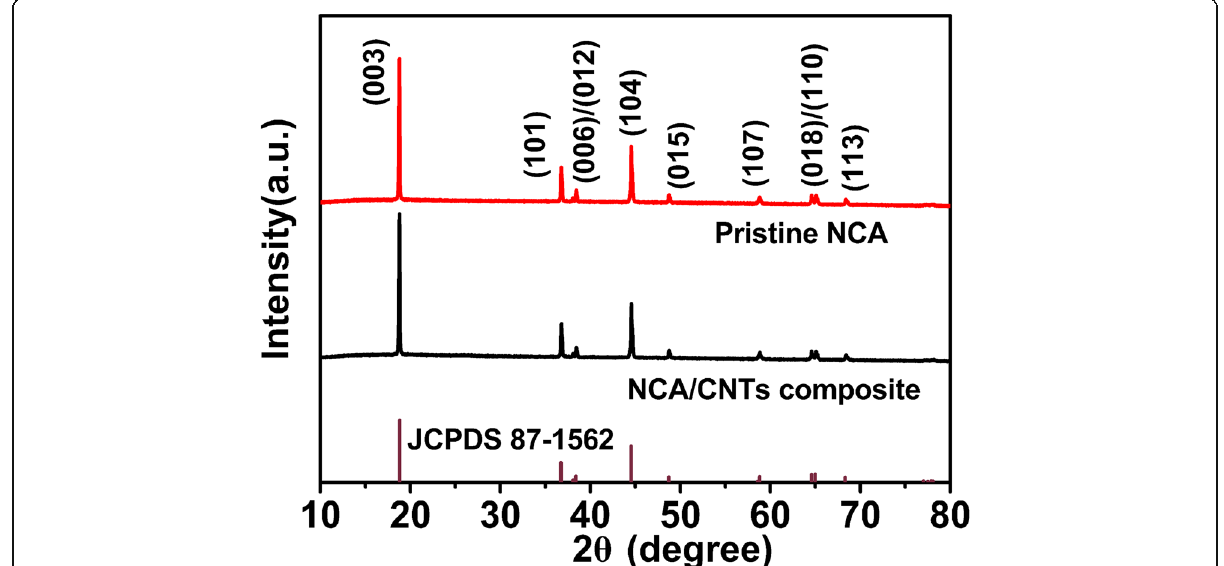
Fig. 3 XRD patterns of pristine NCA and NCA/CNT (10 wt%) composite